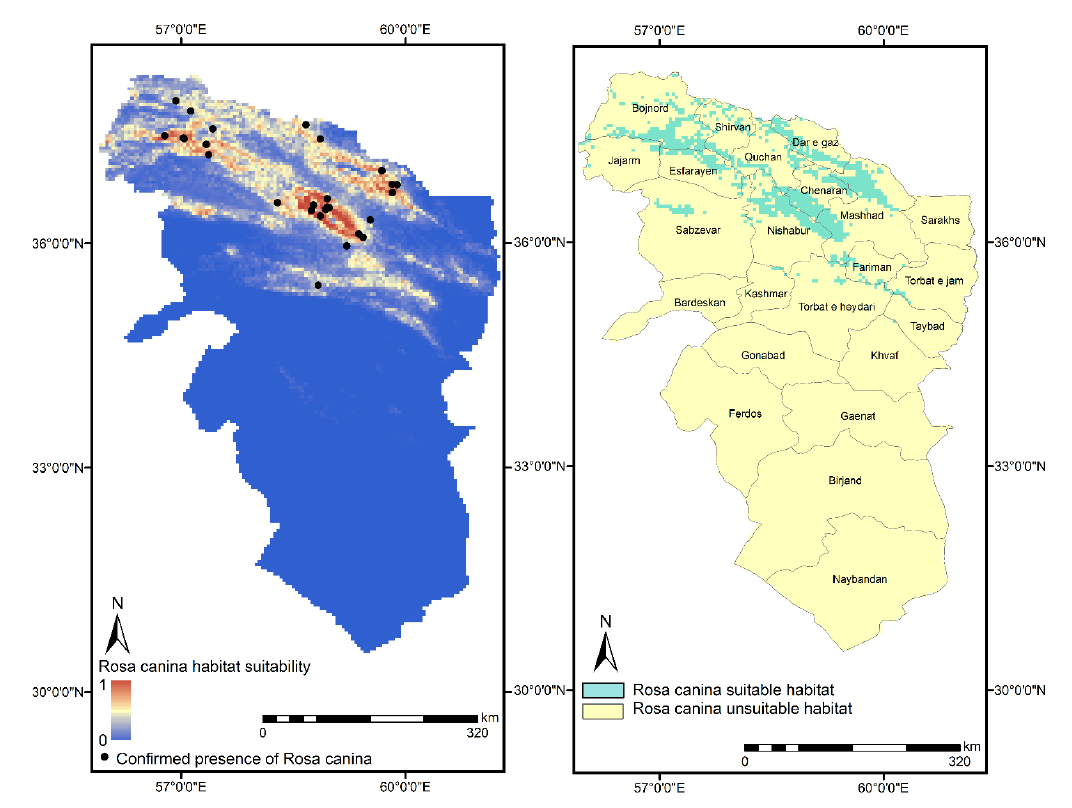
Fig. 1: Habitat suitability of Rosa canina and its suitable habitats in the cities of Khorasan region.